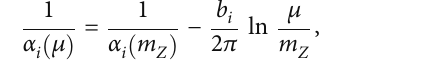
Table 3: Values of Yukawa and gauge couplings evaluated at t = ln ð 10 13 GeV Þ = 29 : 93 for tan β = 40 , for di ff erent choices of m scale.